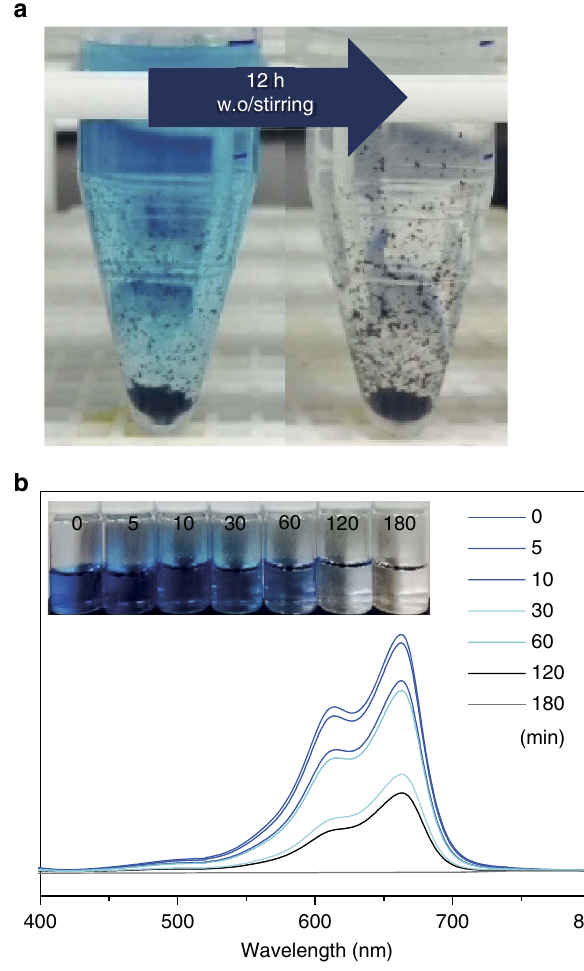
Figure 3 | Monitoring the organic molecule uptake of the nanoporous network. ( a ) Colour change of MB solution by soaking with COP-99 overnight. ( b ) ultraviolet–visible absorption spectra of aqueous MB treated with COP-99 at different interval. The inset photograph shows the corresponding colour change of the MB